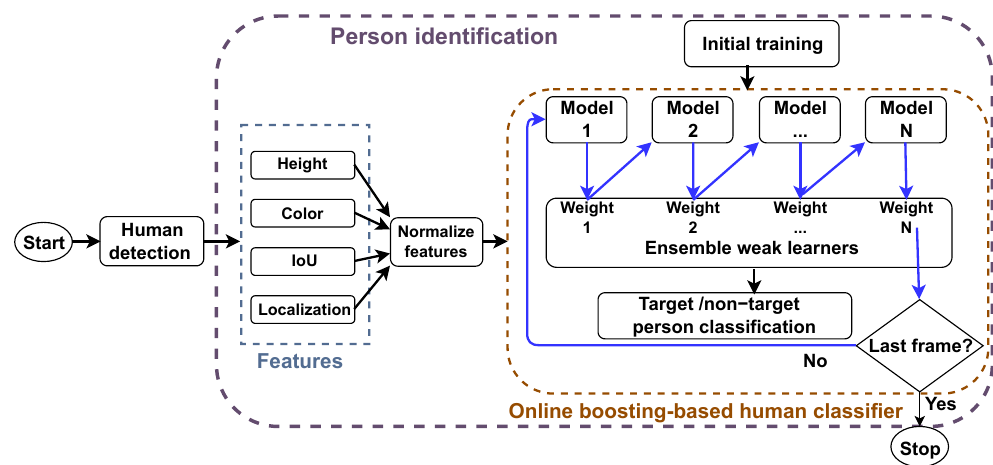
Figure 1. Flowchart of the proposed